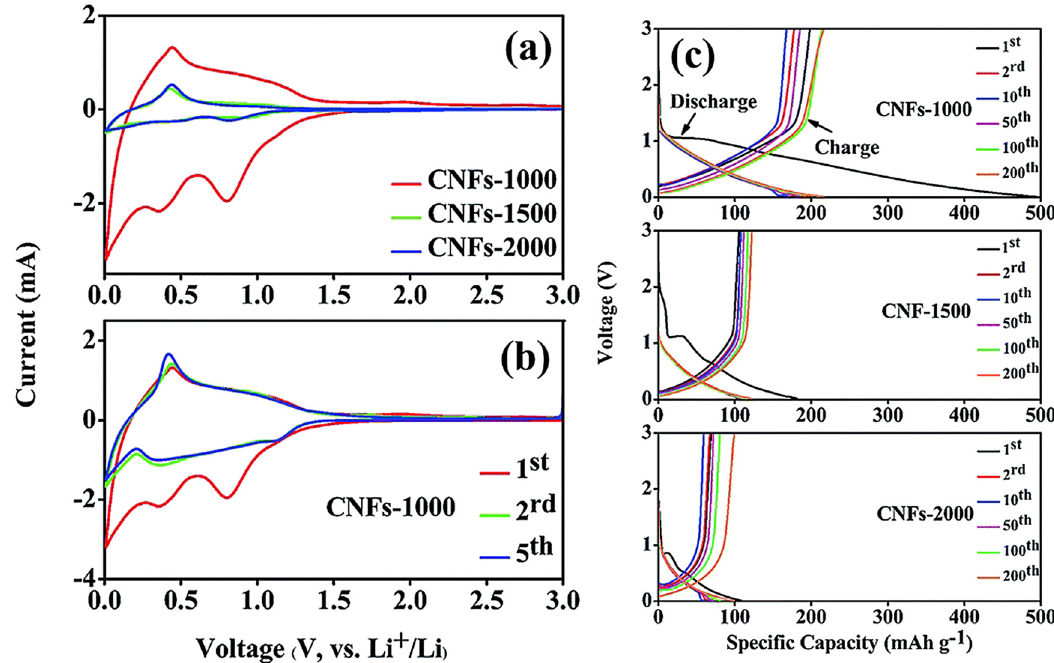
Figure 38: CV curves of CNFs at fi rst cycle ( a ) , and CNFs - 1000 at fi rst fi ve cycles ( b ) , charge/discharge curves ( c ) . Adapted with permission from Ref. [ 419 ] , Royal Society of Chemistry, 2018.